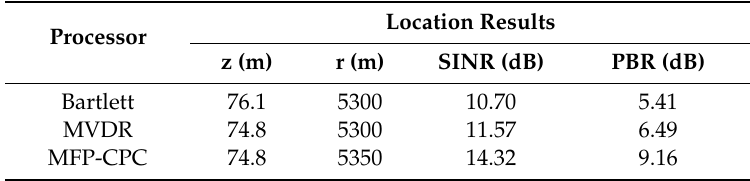
Table 2. Results of the moored source at the second